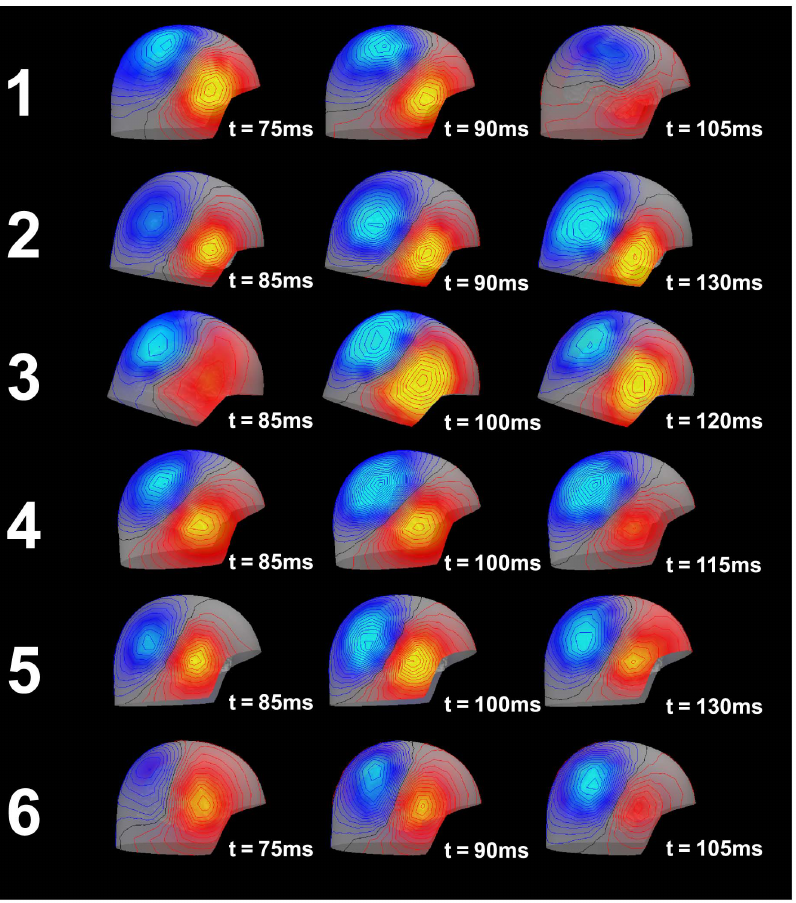
Figure 4. Field mapping of the observed MEG over the right hemisphere. During the development of the N100m peak, the pattern clearly suggests a single dipole located in the right superior middle temporal lobe near Heschl’s gyrus.